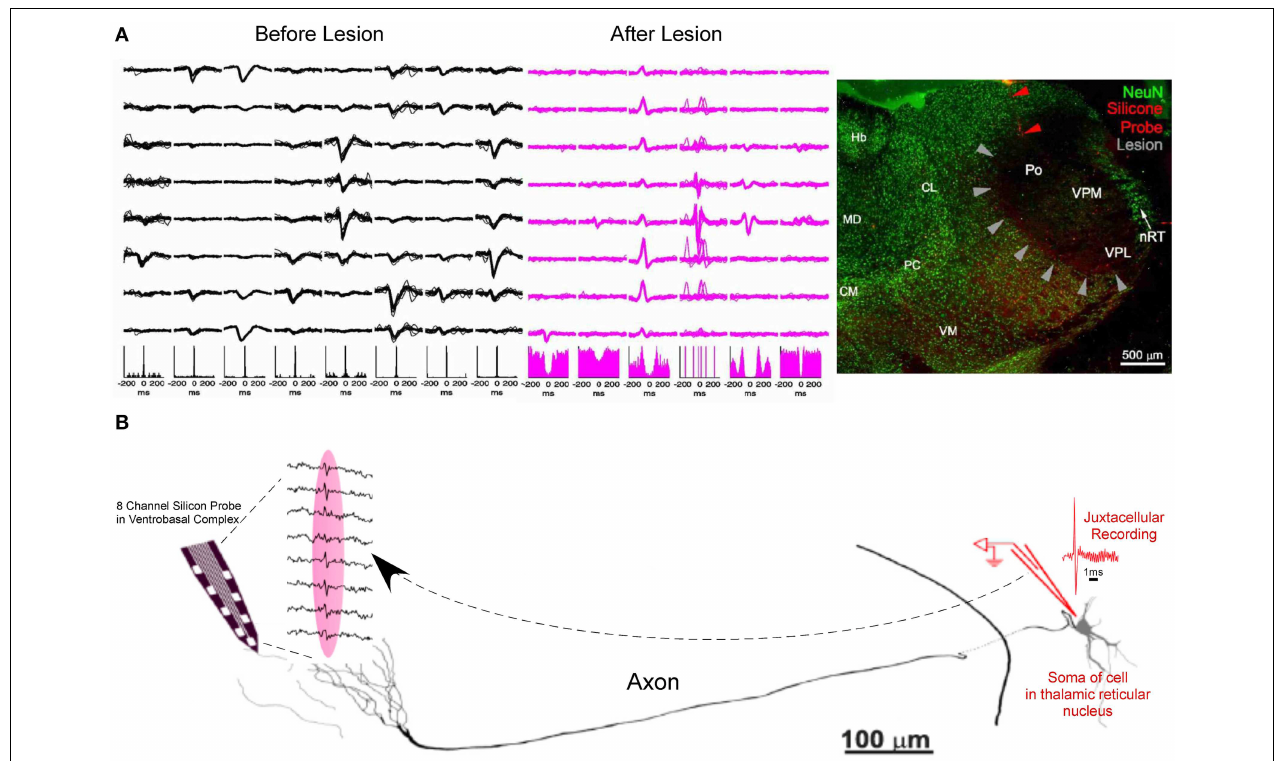
of thalamocortical cells in the ventrobasal thalamus (gray arrowheads) in the vicinity of the recording site (Red arrowheads) (Right). (B) Camera lucida drawing of a juxtacellularly recorded and labeled reticular neuron (spike shown in red) with simultaneous extracellular recording of its axonal arbor in the ventrobasal thalamus (traces from 8 recording sites are shown between dashed lines). Juxtacellularly recorded action potentials from the soma were time-locked with probe recordings from the axons with a conduction delay of less than 0.5ms (Adapted with permission from Bartho et al.,